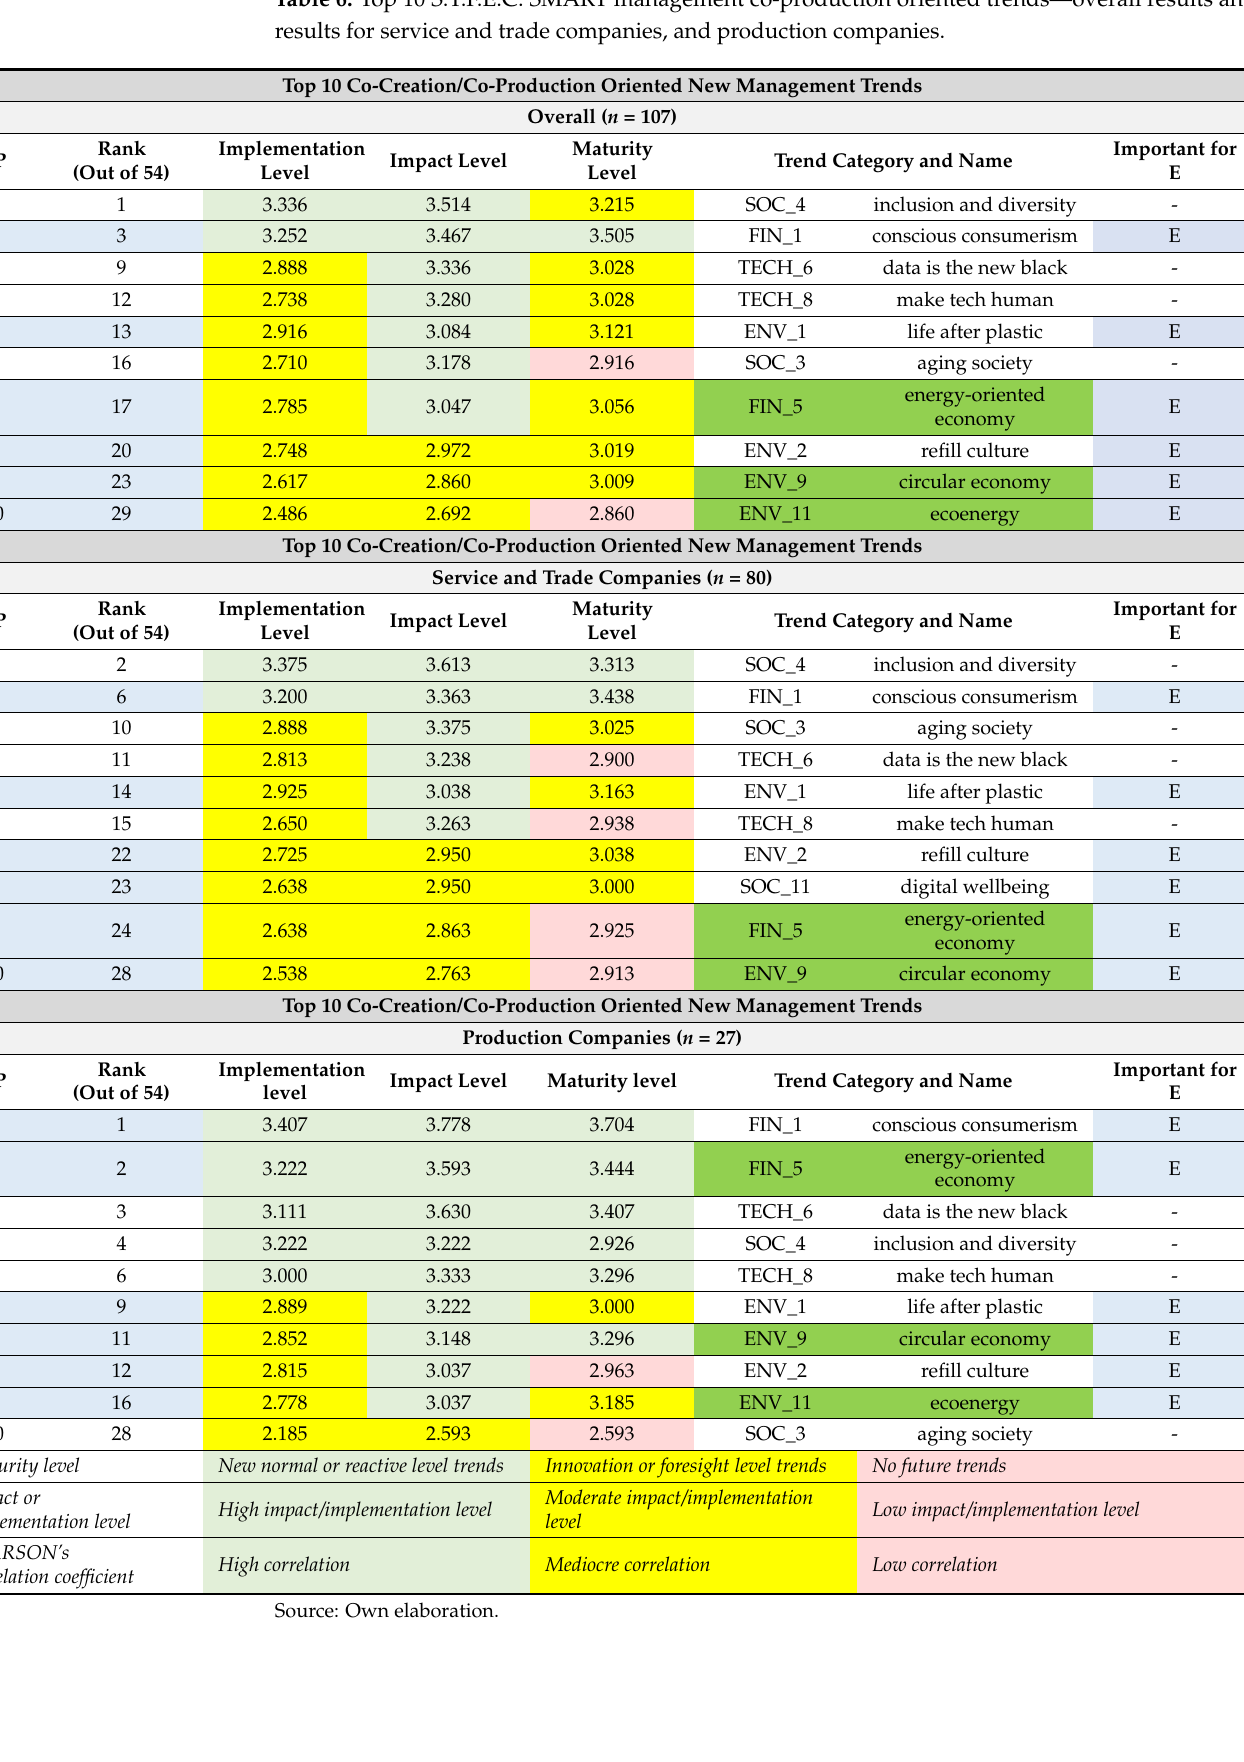
Table 6. Top 10 S.T.F.E.C. SMART management co-production oriented trends—overall results and results for service and trade companies, and production